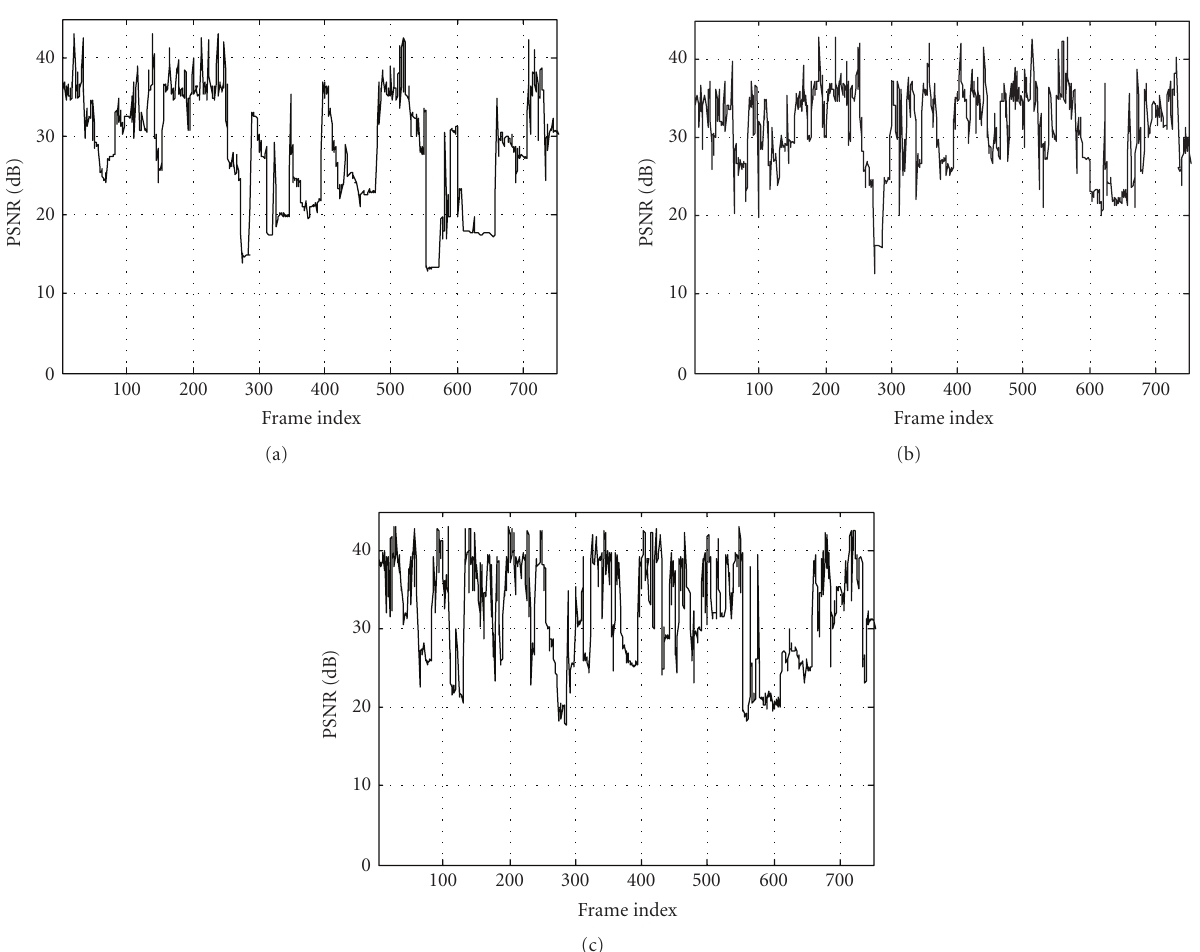
Figure 14: PSNR for the test video under (a) infinite ARQ with DAB; (b) adaptive ARQ with DAB; (c) FLC ARQ with DAB.